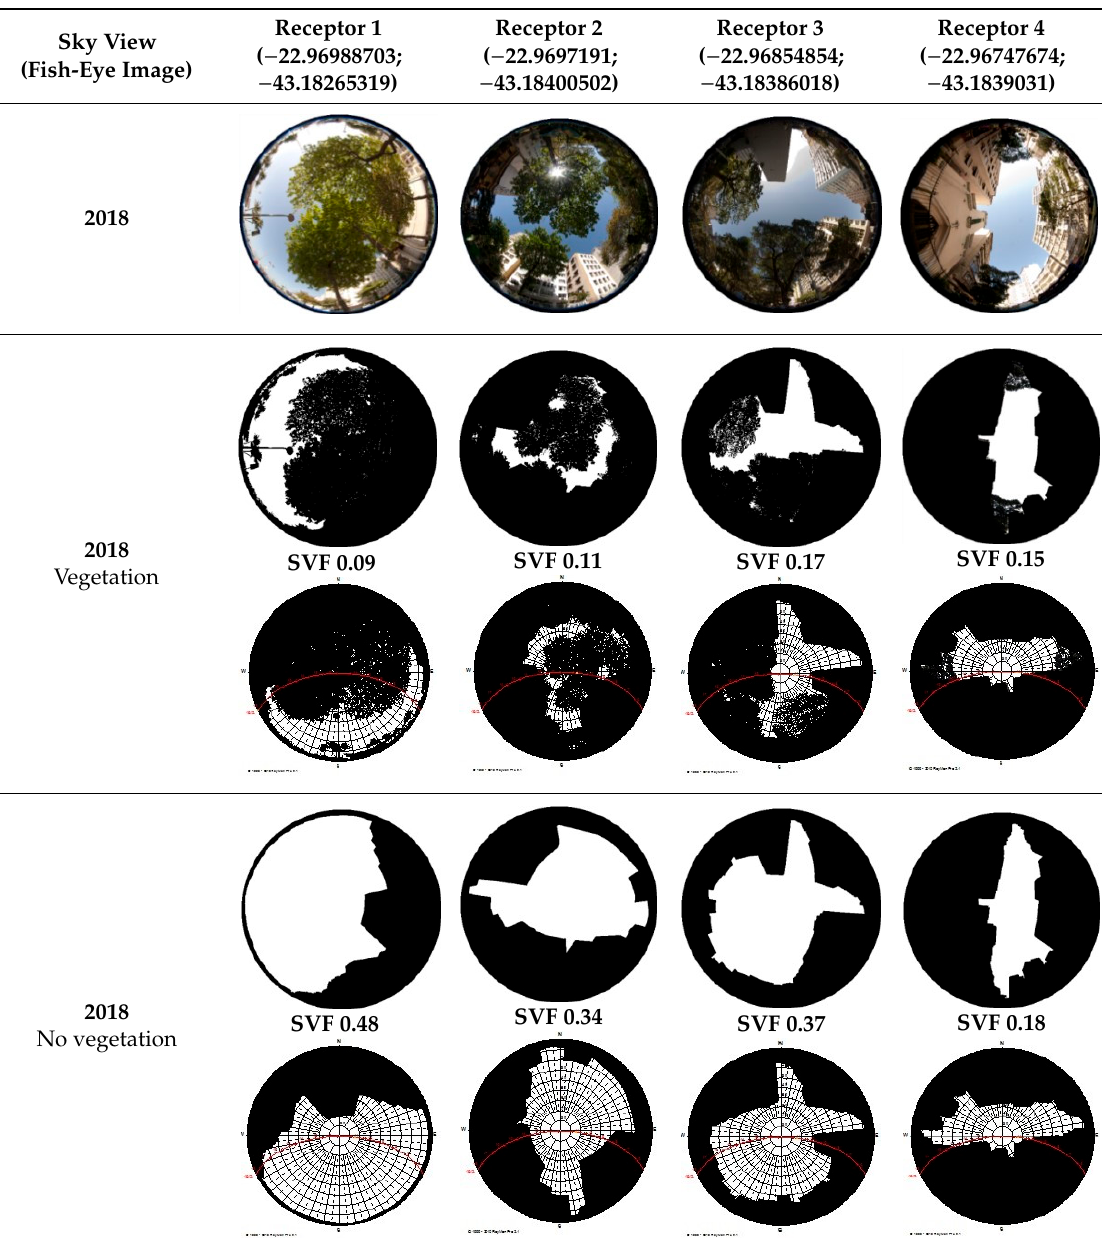
Table 1. Images of the sky taken with a fisheye lens, black and white masks, sky view factor (SVF), and the solar path.